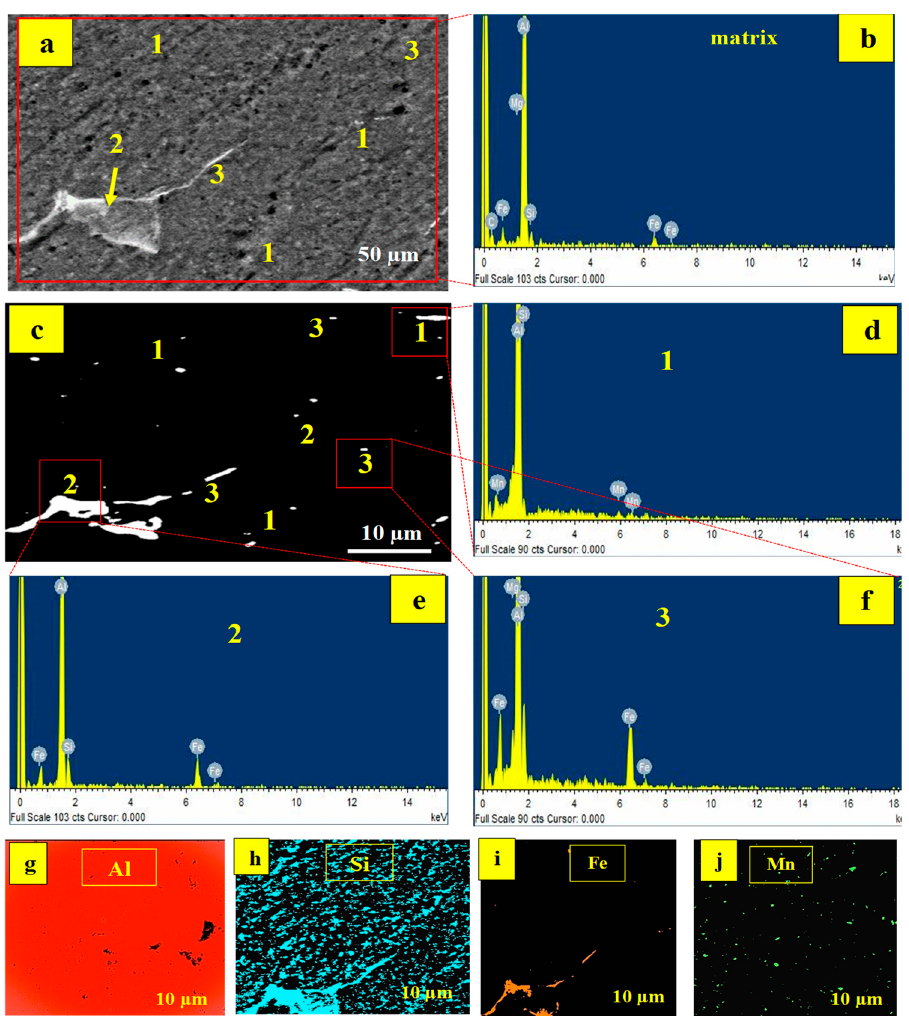
Figure 5. Morphology of specimens cast at 900 °C with a formulation of 4% PKA/6% RHA expressed in ( a ) SEM image ( b ) EDS result for the matrix ( c ) polarized illumination (Amscope 40× − 1000× fluorescence microscope) and EDS results on ( d ) spot 1 ( e ) spot 2 ( f ) spot 3 ( g – j ) elemental maps.